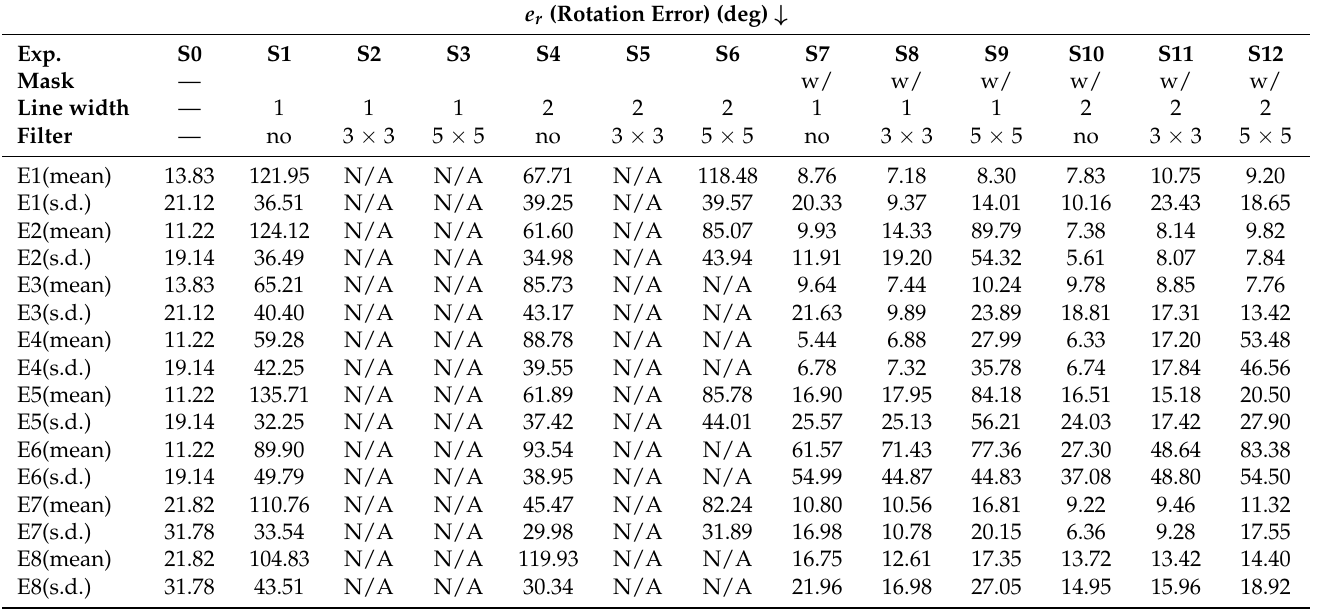
Table 3. Rotation error. S0 is the previous method. S1~S12 are the proposed methods. ’s.d.’ means standard deviation. N/A means the training is not converged. ↓ means lower value is more